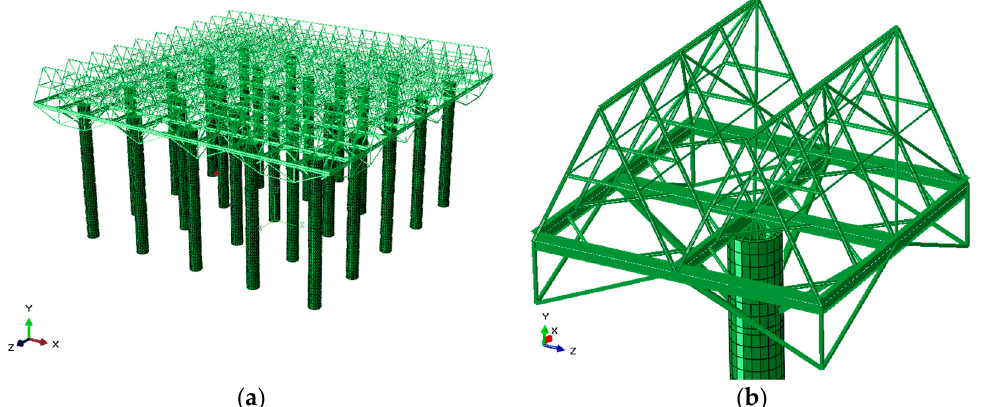
Figure 6. FE (Finite element) model of the steel solid web girder-RC tubular column hybrid structure: ( a ) Whole model; ( b ) part of the model.